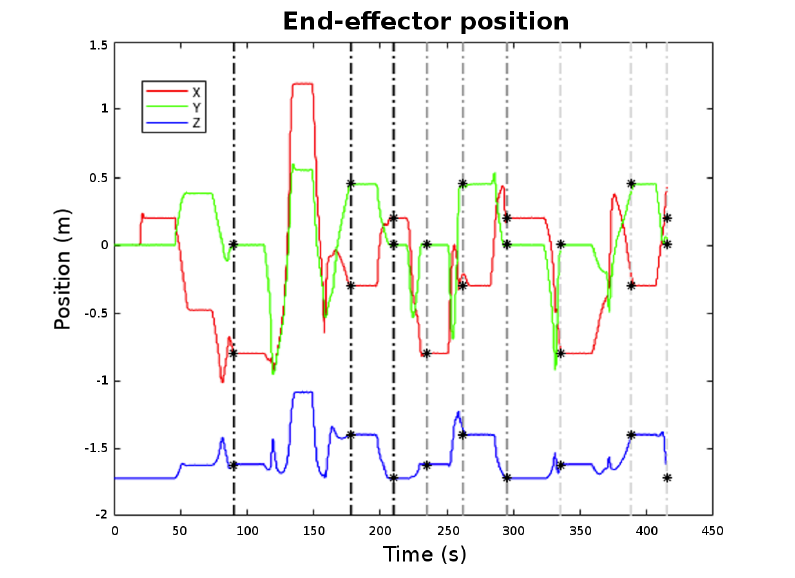
Figure 13. End-effector position with different way-points